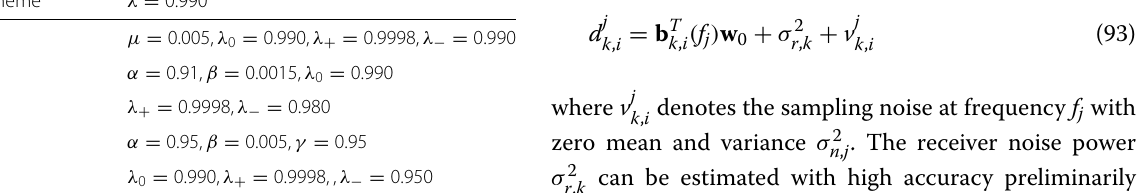
Table 5 Optimized parameters for different algorithms considered in Figs. 10, 11, 12, and 13 Fixed